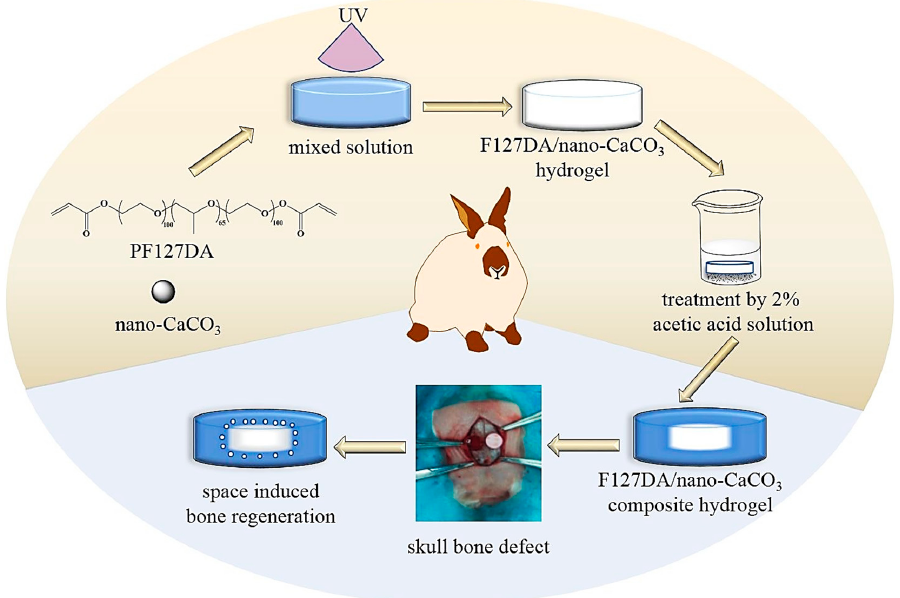
Figure 4. Scheme of a CaCO 3 -loaded hydrogel with triggered Ca 2+ release under exposure to acid media. Reproduced with permission from [11].